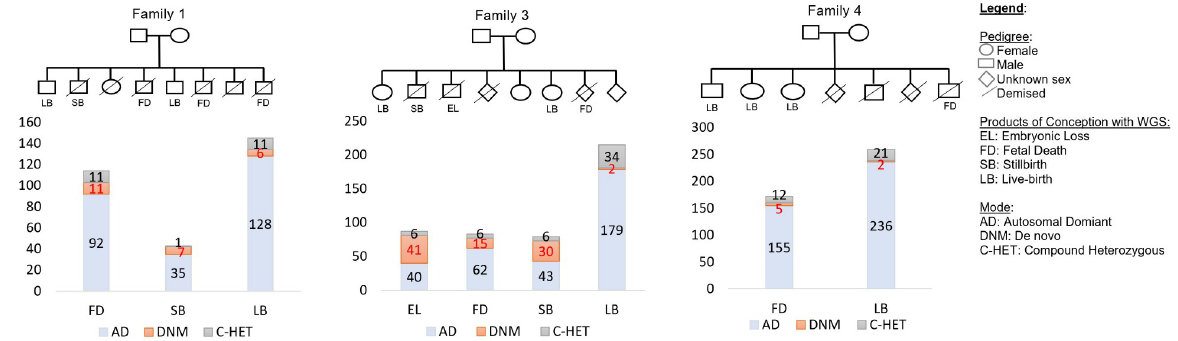
Fig 1. Number of SNVs by modes of inheritance and products of conception.